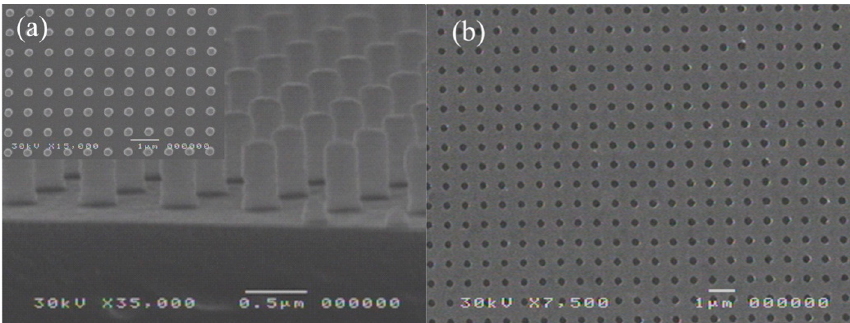
Figure 2. Scanning Electron Microscopy (SEM) photograph of the photoresist template on the glass substrate ( a ). The inset shows the top-view of the template. ( b ) Top-view of the array of holes recorded in the Au film after the lift-off of the photoresist. Periodicity: 675 nm; diameter: 280 nm; gold thickness: 130 nm.